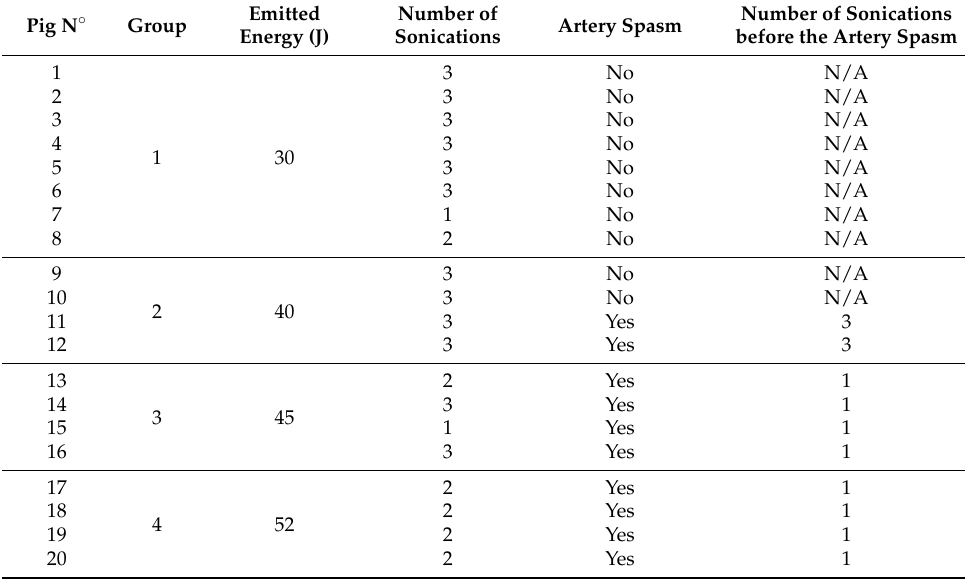
Table 1. Sonication results leading to an artery spasm or not.